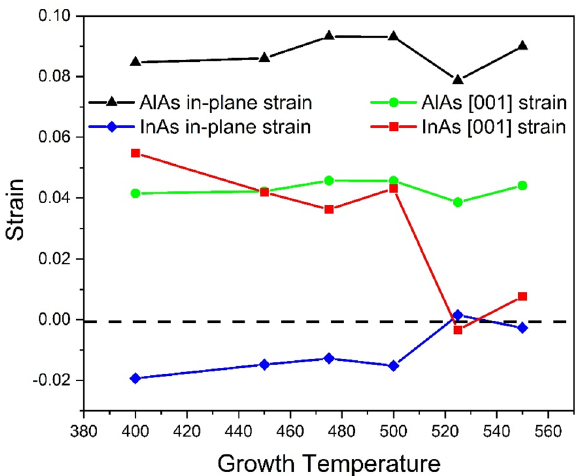
Figure 7. The calculated in-plane strain and the strain along the [001] growth direction for both InAs and AlAs layers in the (InAs) 2 /(AlAs) 2 SPSs grown at different